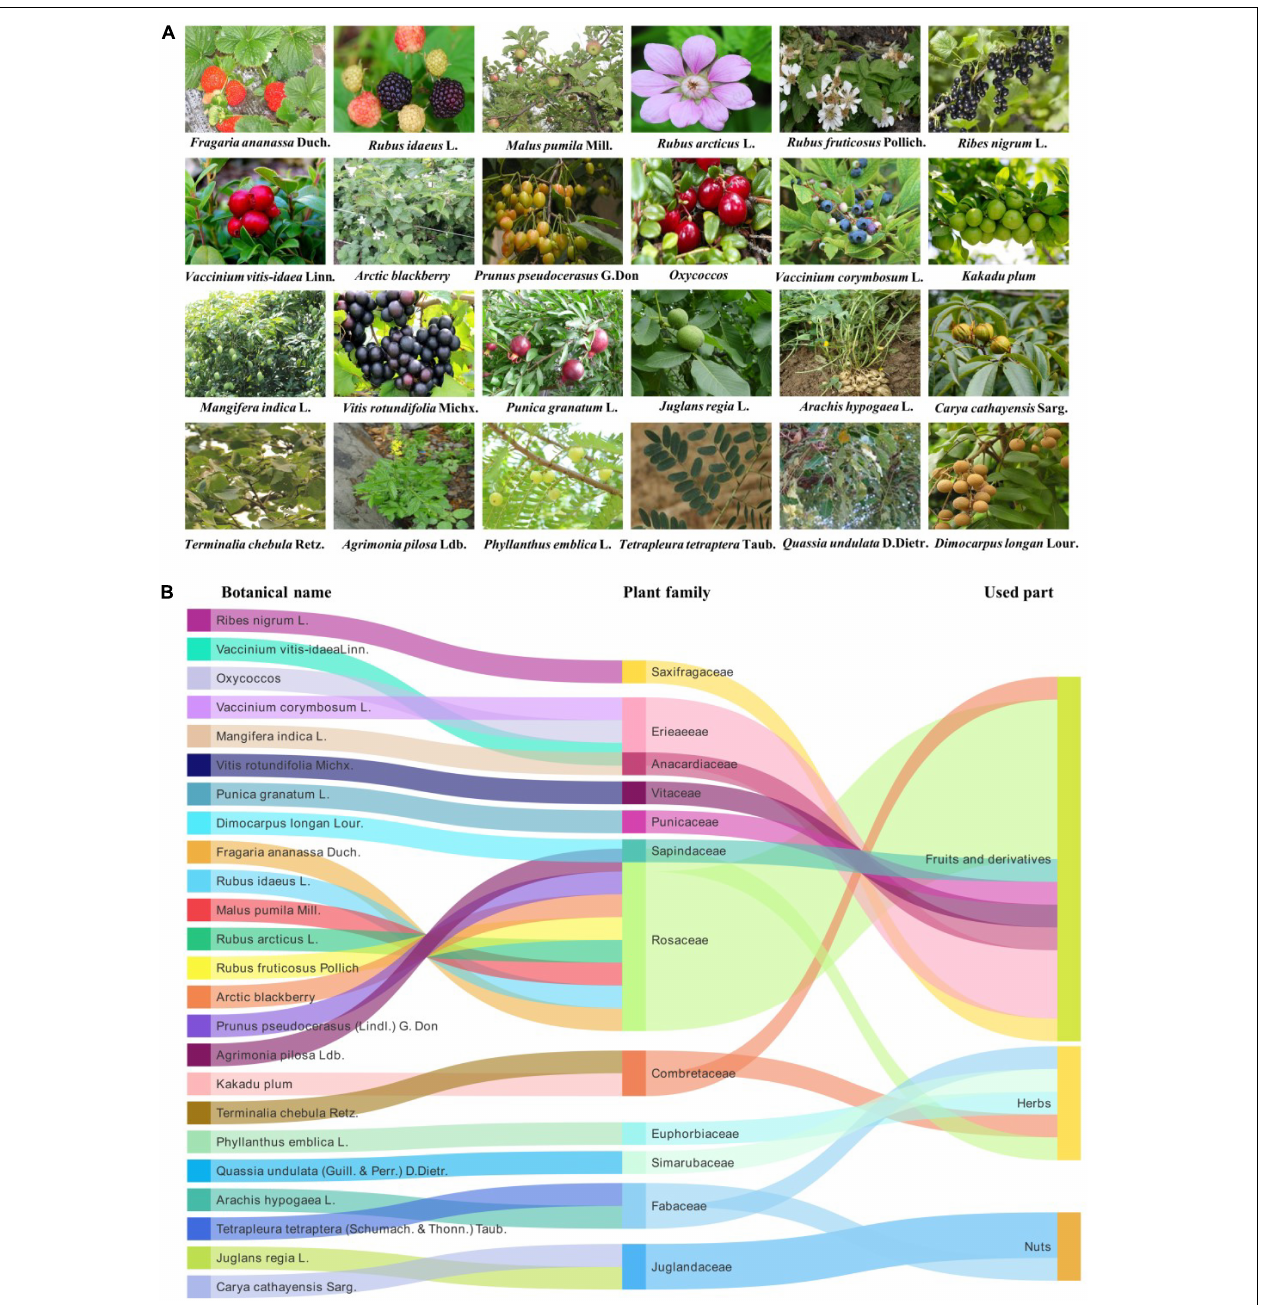
FIGURE 1 | Various sources of ellagic acid (EA). (A) The plant origins of EA. The pictures are from the website: https://www.gbif.org/; http://www.iplant.cn/frps. (B) EA as a major constituent of different fruits, nuts, and